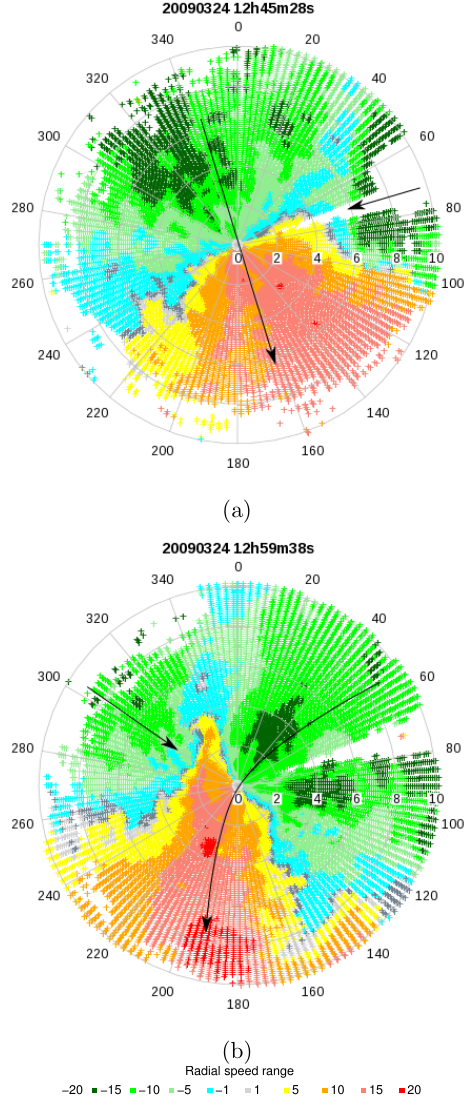
Fig. 15. Radial wind intensity: lidar scan at 13:00UTC (a) , equiva- lent Meso-NH simulated scan at 15:00UTC (b)